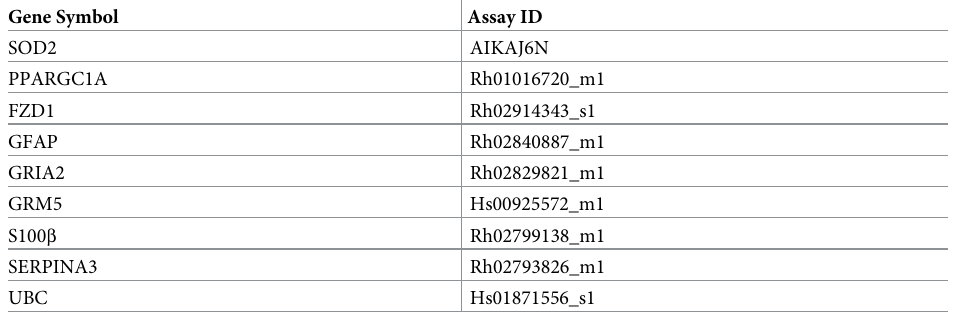
Table 2. TaqMan assay